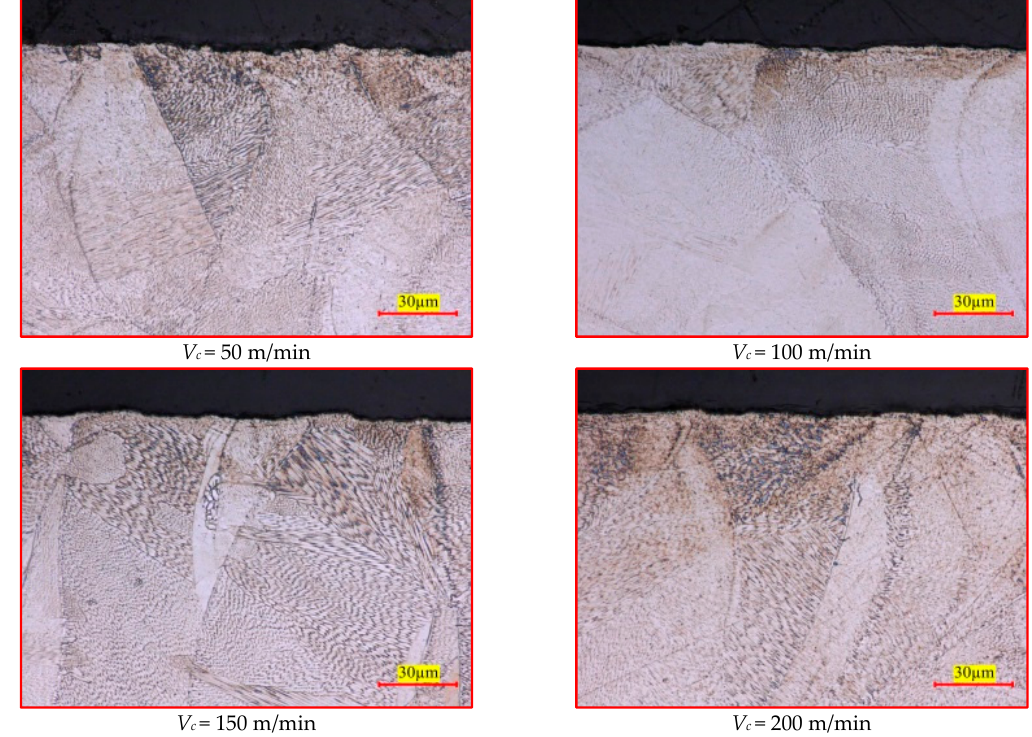
Figure 12. The effect of cutting speed on microstructure of SLMed 316L part ( f = 0.08 mm/rev).